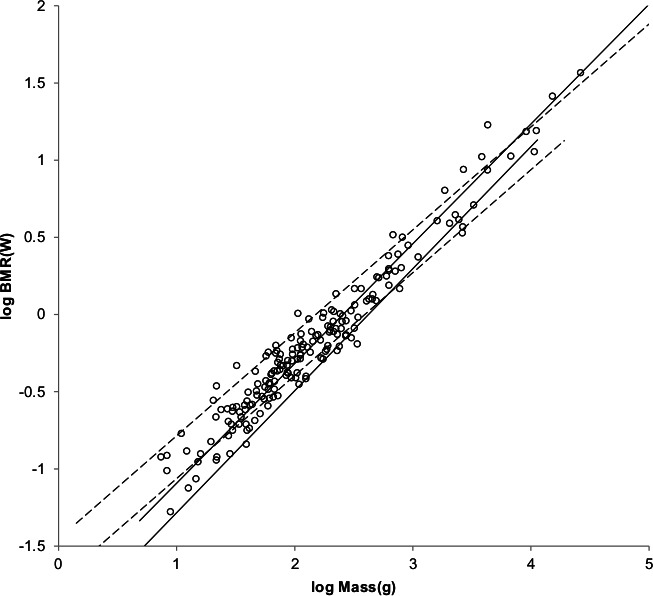
Log BMR as a function of log body mass for non-cricetid rodents.Data are from Kolokotrones et al. (2010). The solid and dashed lines are MMLE sturdiness factor boundaries. The upper boundaries were generated with a sturdiness factor s = (3)0.5. The lower boundaries were generated with s = (3)−0.5. The steeper sloping solid boundary lines are for Froude–Strouhal similarity. The shallower sloping dashed boundary lines are for geometric similarity. The species-averaged non-Cricetidae Rodentia are marked by open circles. \documentclass[12pt]{minimal}
\usepackage{amsmath}
\usepackage{wasysym}
\usepackage{amsfonts}
\usepackage{amssymb}
\usepackage{amsbsy}
\usepackage{upgreek}
\usepackage{mathrsfs}
\setlength{\oddsidemargin}{-69pt}
\begin{document}
}{}${R}_{M}^{2}=0.9966$\end{document}RM2=0.9966 with respect to both sets of boundaries.